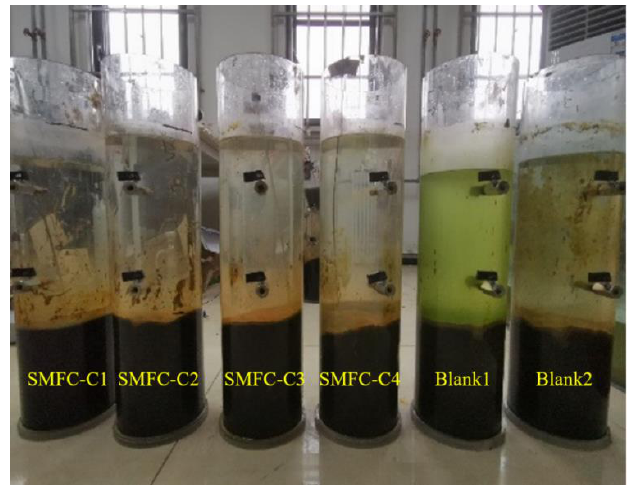
Figure 8. Eutrophication degree of water in different experimental groups.